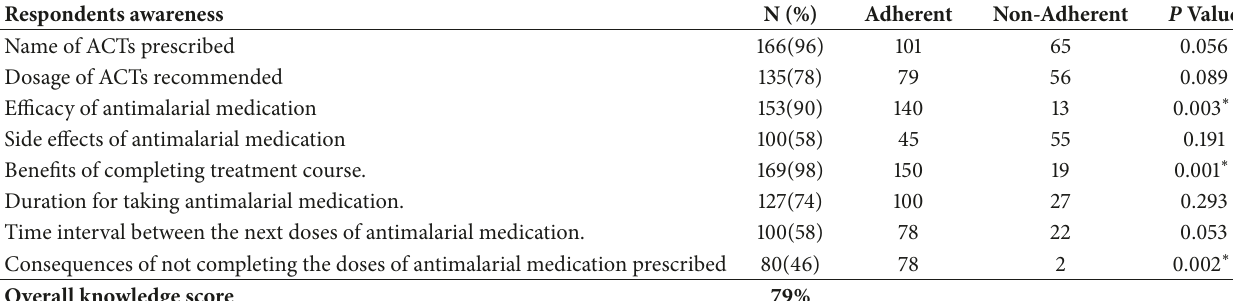
Table 3: Knowledge of treatment of malaria and its relationship to